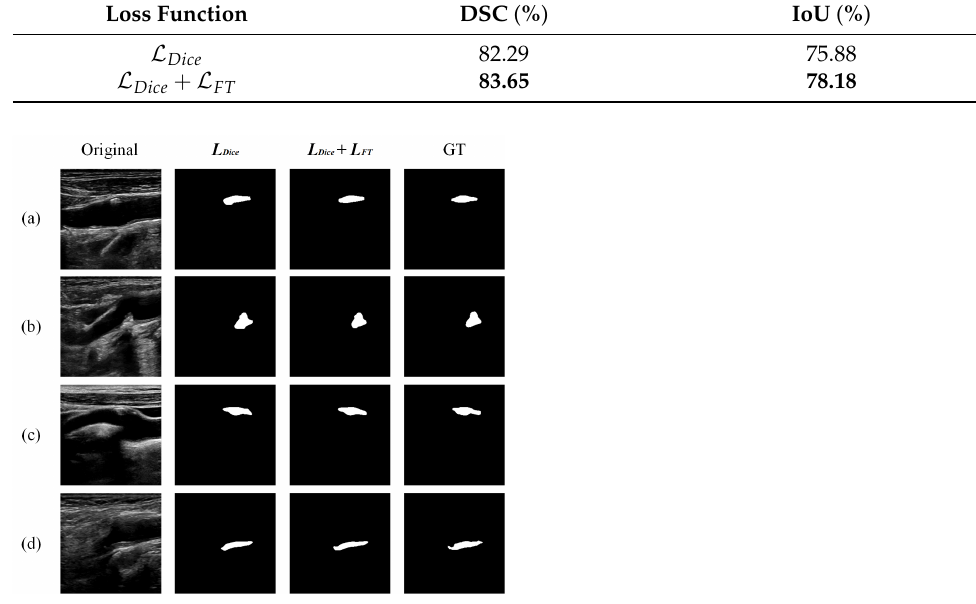
Figure 8. Qualitative comparison of carotid plaque segmentation results produced by different loss functions. ( a – d ) are partial segmentation